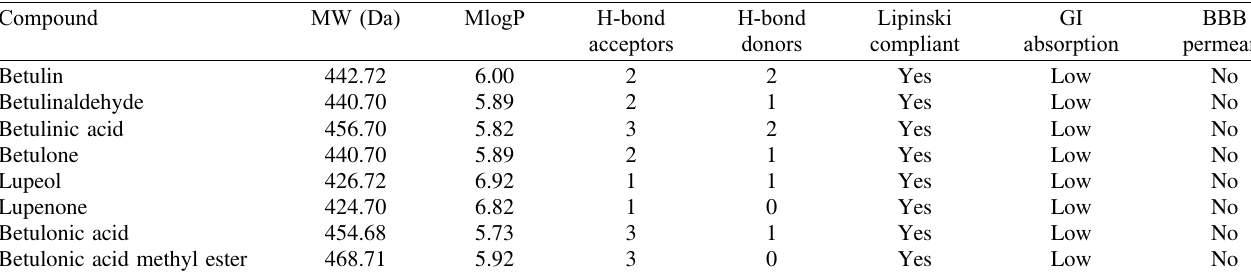
Table 1. Absorption and permeation computation of the eight lupane-type triterpenes. Compound